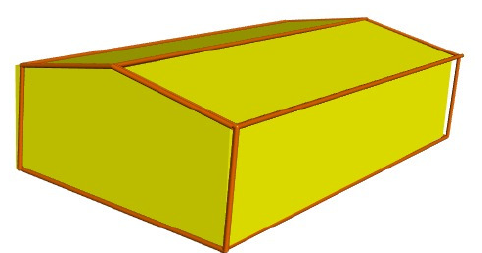
Figure 10. Preliminary result of the application of the PolyFit algorithm on the Candi Sari data